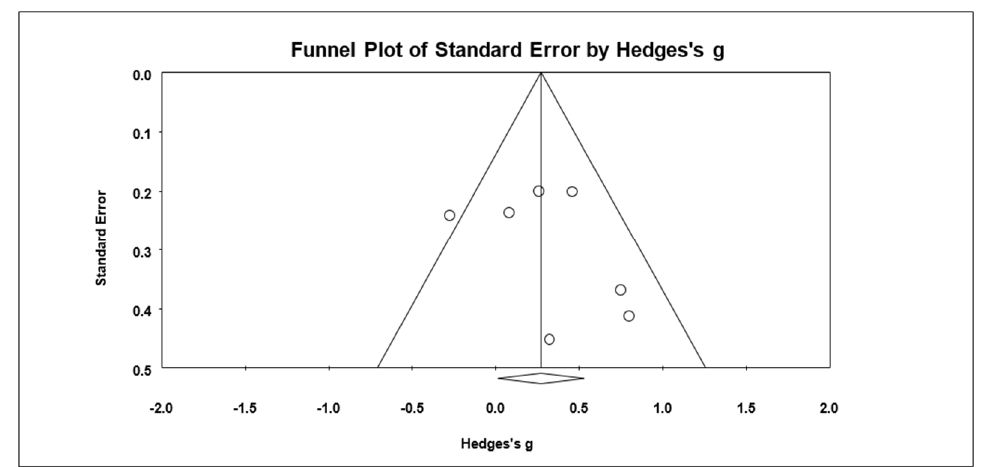
Figure 7. Funnel plot for internalizing behavioral problem.